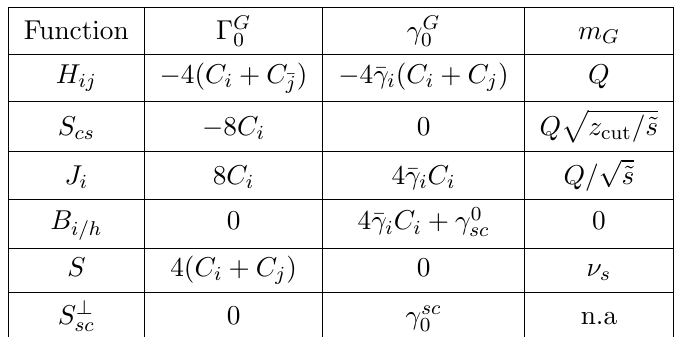
Table 1 . Anomalous dimensions coe(cid:14)cients for up to NLL accuracy: (cid:22) (cid:13) q = 3 = 2, (cid:22) (cid:13) g = (cid:12) and (cid:13) sc = 2 (cid:11) s ( (cid:22) ) C F =(cid:25) ln( (cid:23)=Qz 0